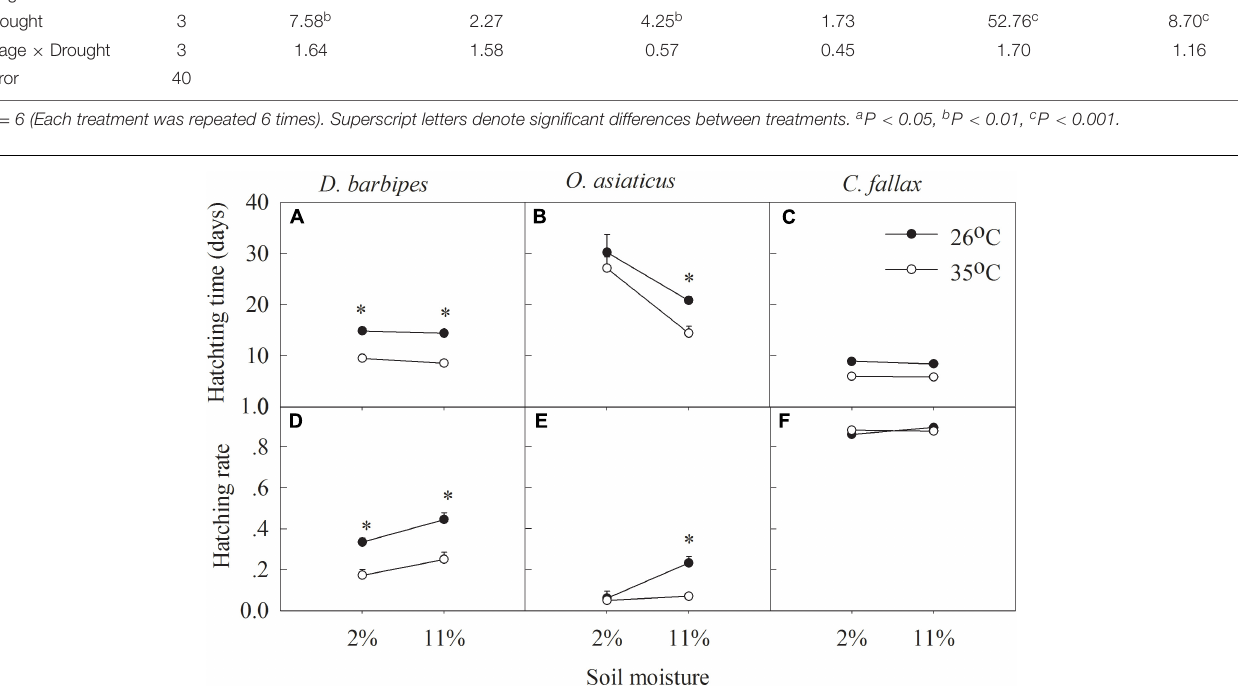
FIGURE 2 | Hatching time (A,B,C) and hatching rate (D,E,F) of eggs of D. barbipes, O. asiaticus and C. fallax in different combined treatments of soil temperature and moisture. Data are mean ± SE ( n = 6). ∗ Indicates a significant difference between the two temperature treatments at the same soil moisture level at P <